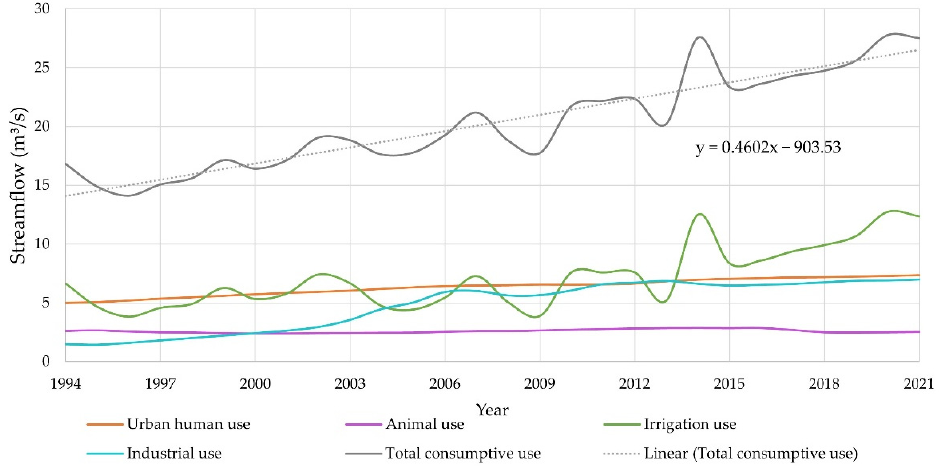
Figure 4. Average water use in hydroelectric plants Luiz Carlos Barreto de Carvalho and Porto Colombia (run-of-river).